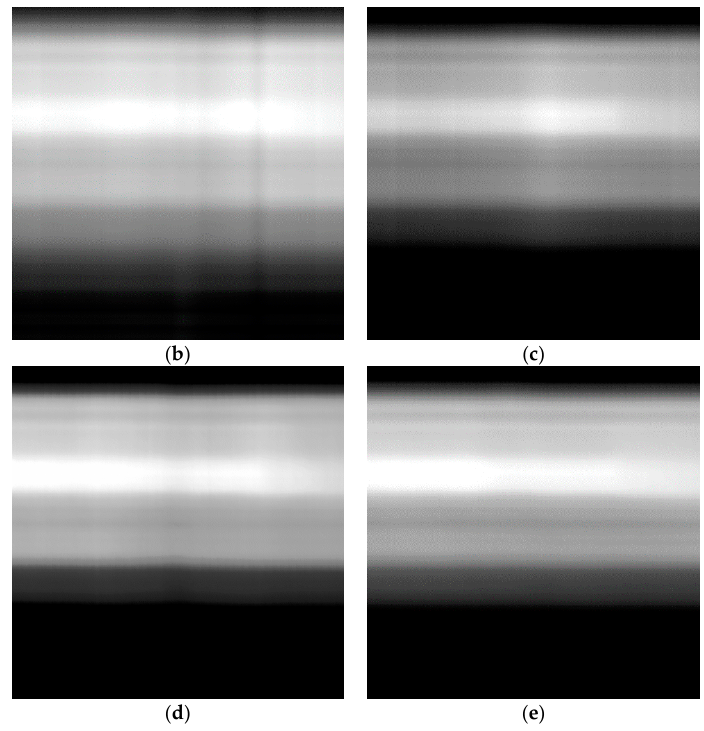
Figure 13. Corrected images of the high-brightness region of the side-slither data (the images were stretched for display): ( a ) raw data for the low-brightness region; ( b ) results obtained using polynomial fitting; ( c ) results obtained using laboratory coefficients; ( d ) results generated using on-orbit coefficients; ( e ) results generated using coefficients obtained by the proposed method.